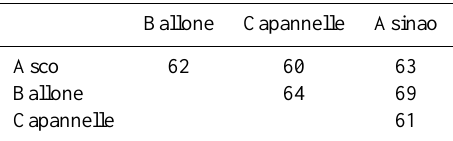
Table 3. Gleichl¨aufigkeits-values (in %) between the chronologies from the different